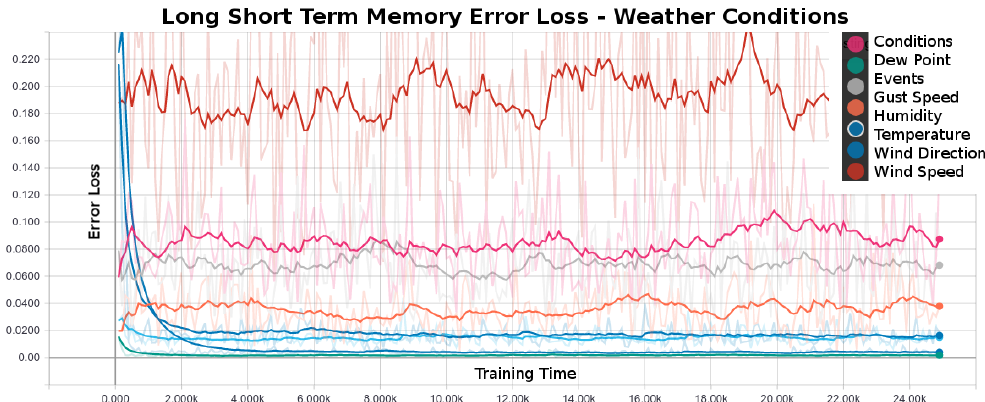
Figure 4. LSTM’s training error loss. Eight resulting plot lines represent each LSTM trained on one weather condition. The plots show error loss during the model training. The termination condition for the model training was set if the model generalized the data with a desired error loss of 1.0 × 10 − 7 or 1.0 × 10 6 training epochs was